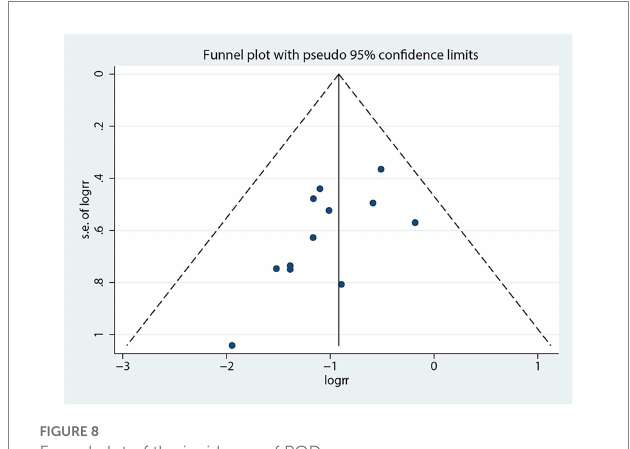
FIGURE 8 Funnel plot of the incidence of